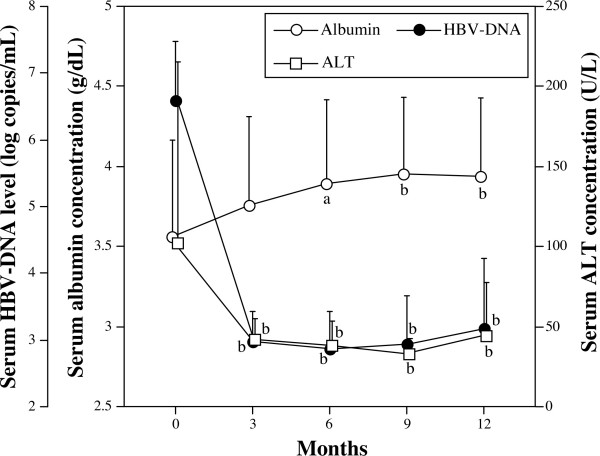
Time course of albumin, HBV-DNA, and ALT levels in lamivudine treatment. The average serum levels of albumin (closed circles), HBV-DNA (open squares), and ALT (open circles) at 3-month intervals from the start of lamivudine therapy are plotted. Soon after the start of treatment, serum albumin levels increased rapidly and simultaneously with a decrease in HBV-DNA and serum ALT levels. The data represent mean + SD (a, b; p < 0.05 and p < 0.01 vs. 0 month, respectively).